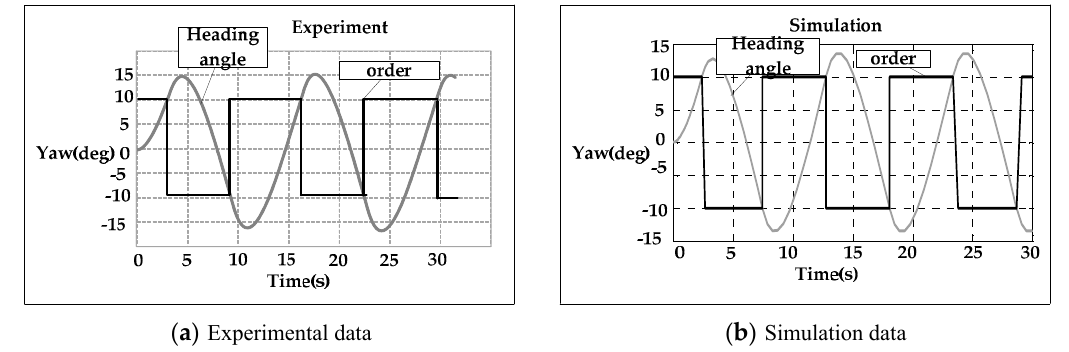
Figure 9 . Yaw of +10 deg zig-zag test: comparisons between simulated and experimental data. Figure 9. Yaw of + 10 deg zig-zag test: comparisons between simulated and experimental data.